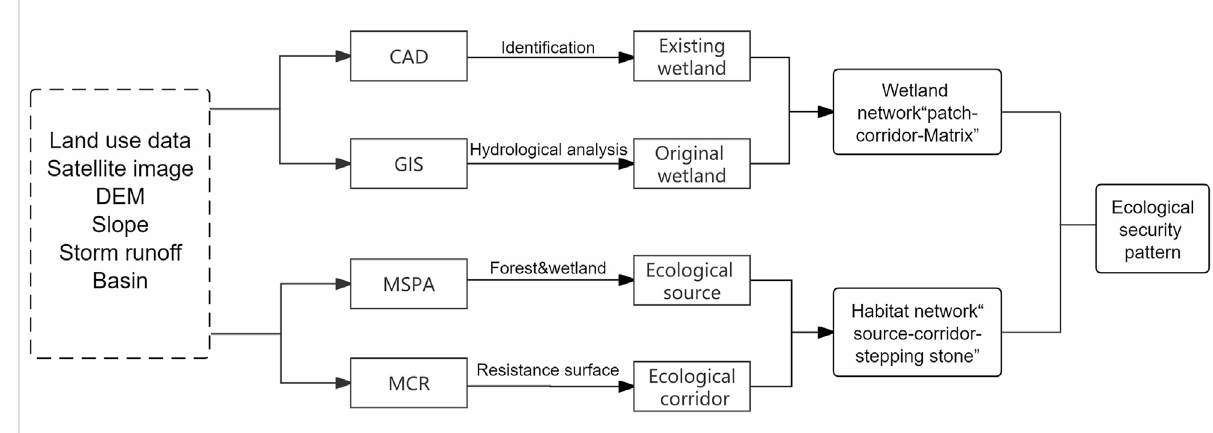
FIGURE 3 Methodological framework used in this study.